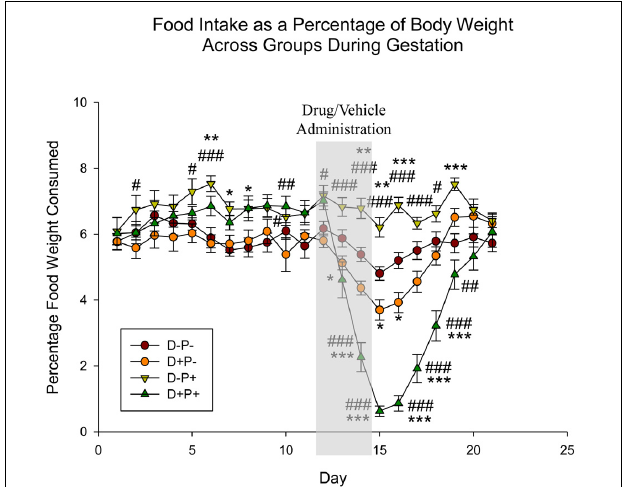
FIGURE 3 | Food intake as a percentage of body weight across gestation period. Pregnancy termination induced a significant reduction in food intake. n = 15–17 rats/group; ∗ p < 0.05, ∗∗ p < 0.01, ∗∗∗ p < 0.001 (Relative